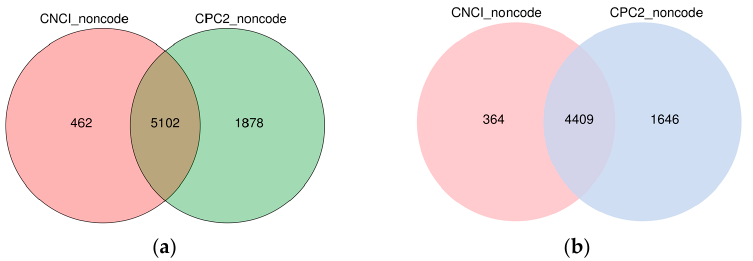
Figure 1. Venn Diagram of novel lncRNAs by coding capacity analysis at different time courses. ( a ) 36 h post-infection. ( b ) 72 h post-infection. CNCI indicates Coding-Non-Coding-Index and CPC2 indicates Coding Potential Calculator.